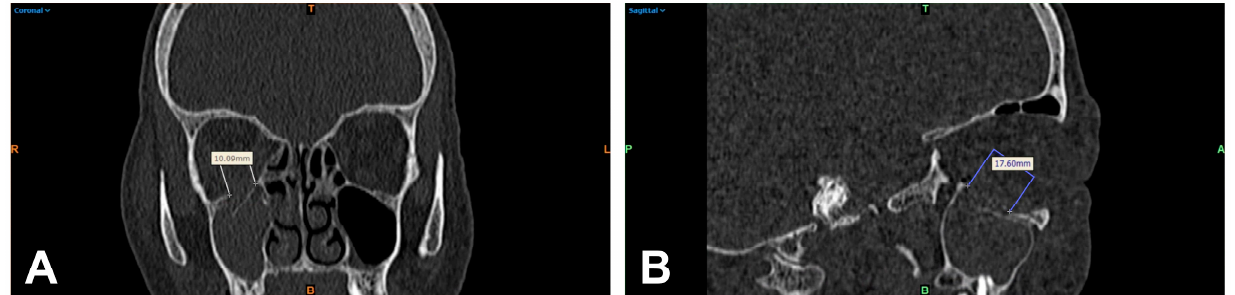
Figure 1. Multiplanar reformation of a patient’s midface (bone window) after orbital trauma: linear 2D measurement of the visible orbital wall defect of the right orbita in mediolateral extension in the coronal reformation ( A ) and anteroposterior extension in the sagittal image ( B ). R = right; T = top; L = left; colored B = bottom.